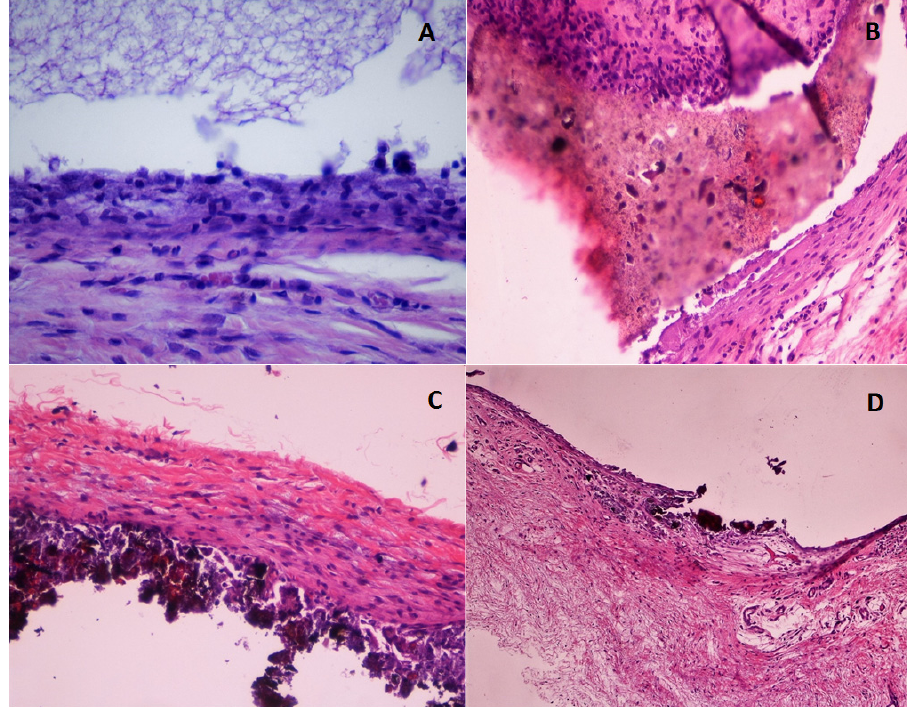
Figure 1. Hematoxylin–eosin stain. ( A ): Control. Fibrous capsule 30 days (×400). ( B ): Theracal LC